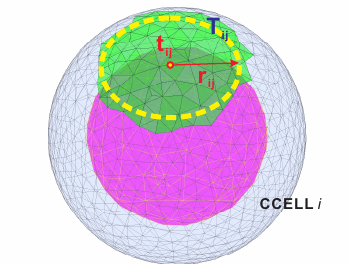
Figure 9. Illustration of tunnel. Nodes in green area are the intersection nodes in CCELL i . t T ij is the center of tunnel ij . The area (on the spherical surface) enclosed by the yellow circle with radius r ij centered at t ij is tunnel T ij